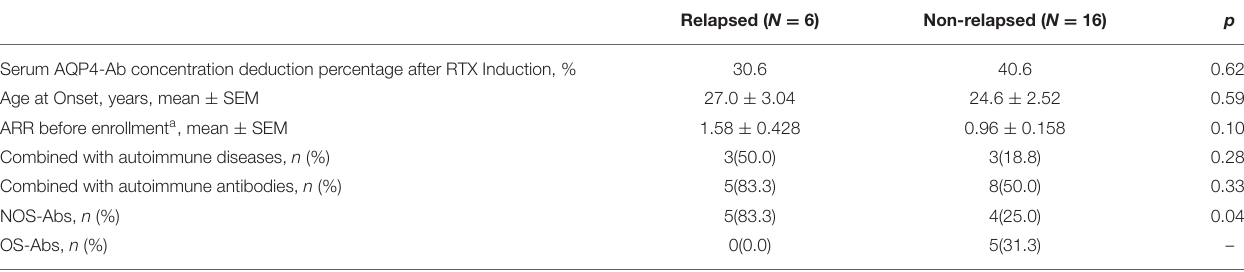
TABLE 2 | Comparison of clinical characters between relapsed and non-relapsed patients within 6 months of RTX treatment. Relapsed ( N = 6) Non-relapsed ( N = 16) p Serum AQP4-Ab concentration deduction percentage after RTX Induction, %